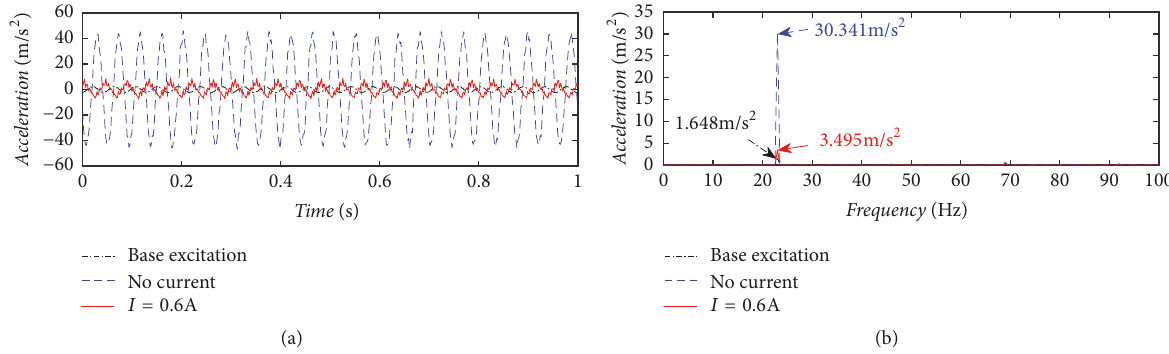
Figure 12: Isolation performance of the isolator for a base excitation frequency of 23Hz: (a) time domain and (b) frequency domain.